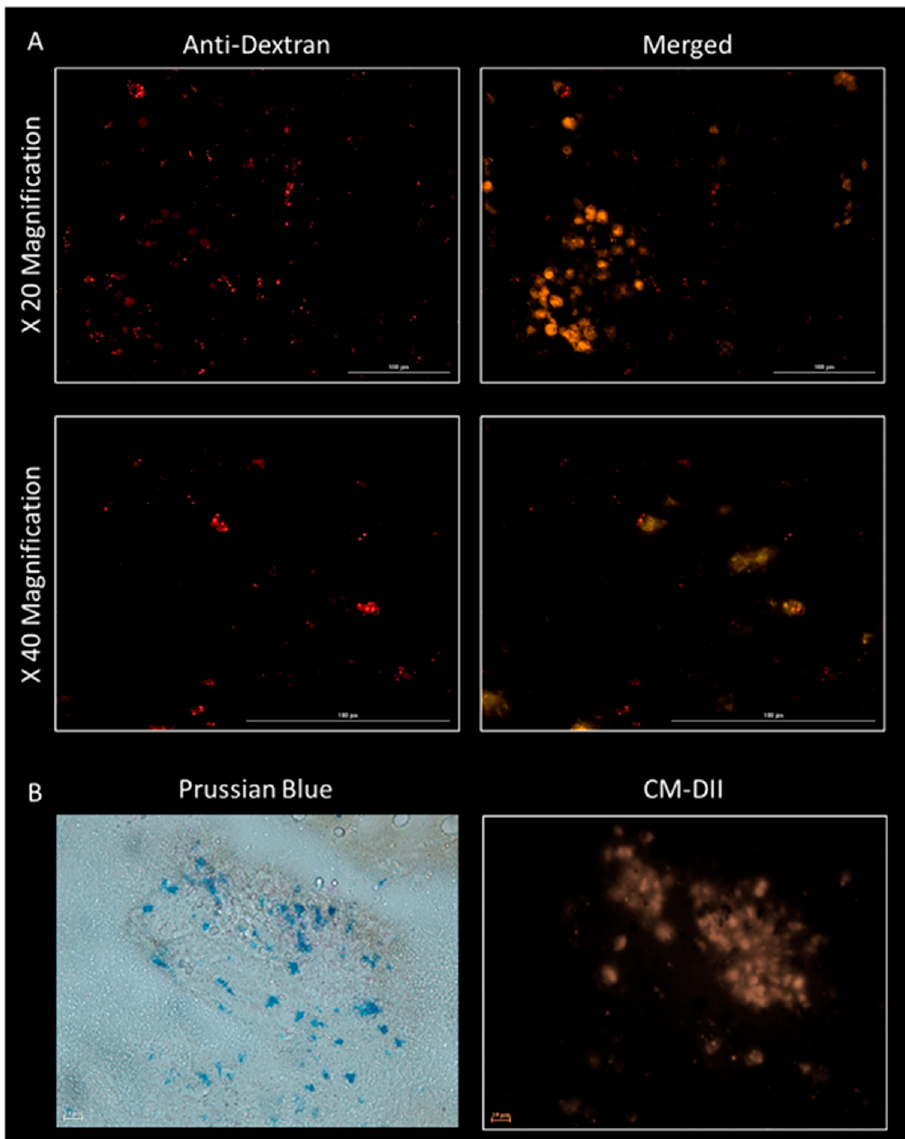
Figure 6. Assessment of MNP degradation in vivo MNPs are composed of an iron oxide core with a dextran coating. ( A ) Immunohistochemistry for dextran (Red Fluorescence). ( B ) Prussian blue staining for the iron oxide core (Blue staining). Implanted oMSCs are identified by the orange membrane-bound stain attributed to the CM-Dil dye. Representative day 7 sample. Scale bar = 100 µm.